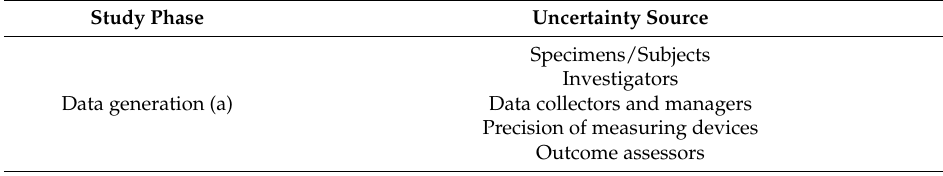
Table 1. Sources of